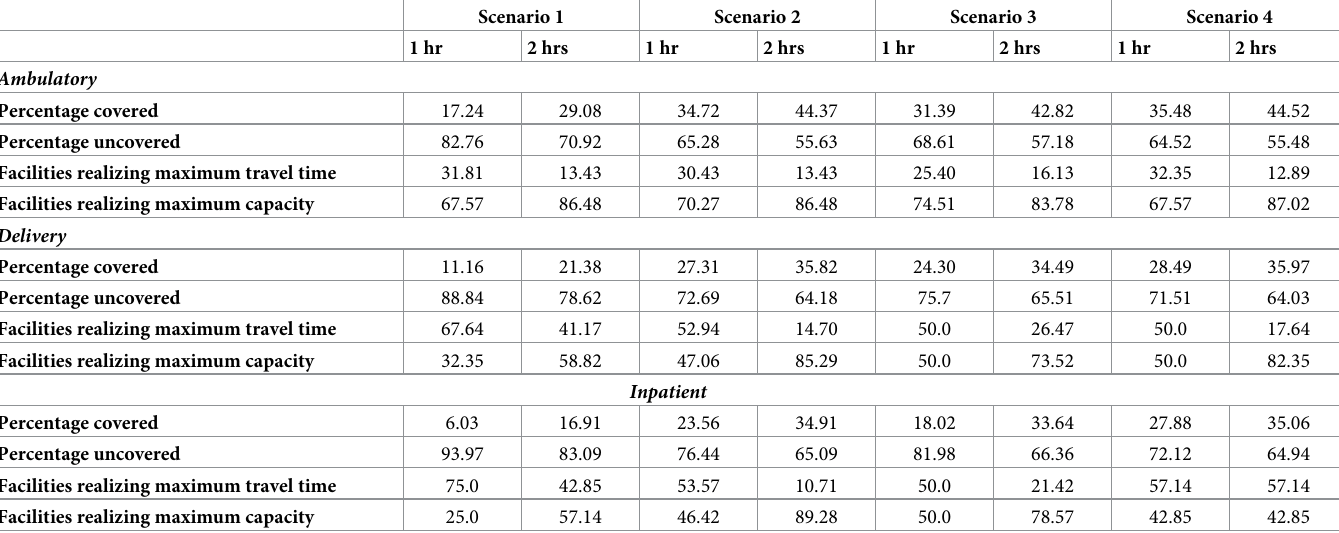
Table 5. Distribution of population served in each travel time catchment by travel Scenario.